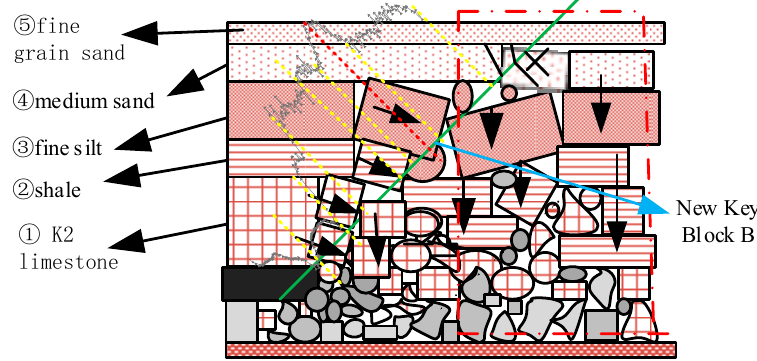
Figure 31. Schematic diagram of rock formation deformation on the fiber-optic section on 10 September.